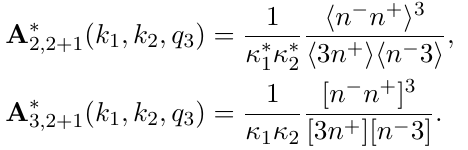
Figure 14 . Typical Feynman diagrams contributing to (5.33) i.e. to the BFKL kernel at LO in = 4 SYM. At large center of mass energy √ s and fixed momentum transfer √ N totical behaviour of an amplitude is given by its imaginary part [50, 70]: Grey squares represents impact factors, wavy lines represents gluon propagators, vertical red line represents cuts of corresponding propagators and impact factors. Diagrams of type A) gives con- tribution to K V and their total sum is equivalent to evaluation of (5.53). Diagrams of type BFKL